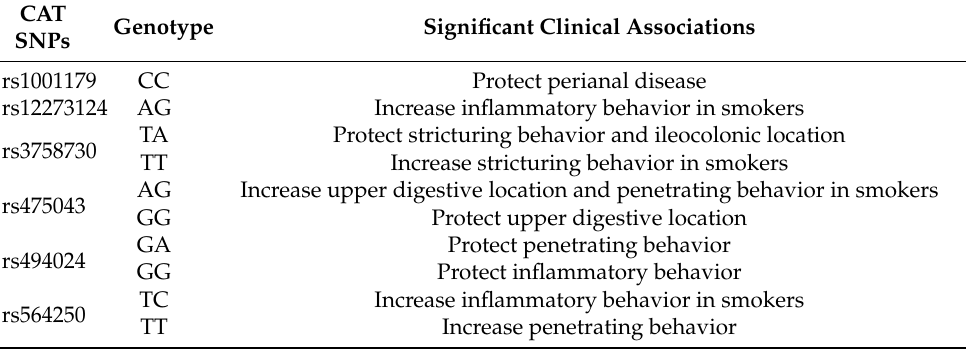
Table 2. Genotype association analysis of CAT SNPs with clinical variables of discovery